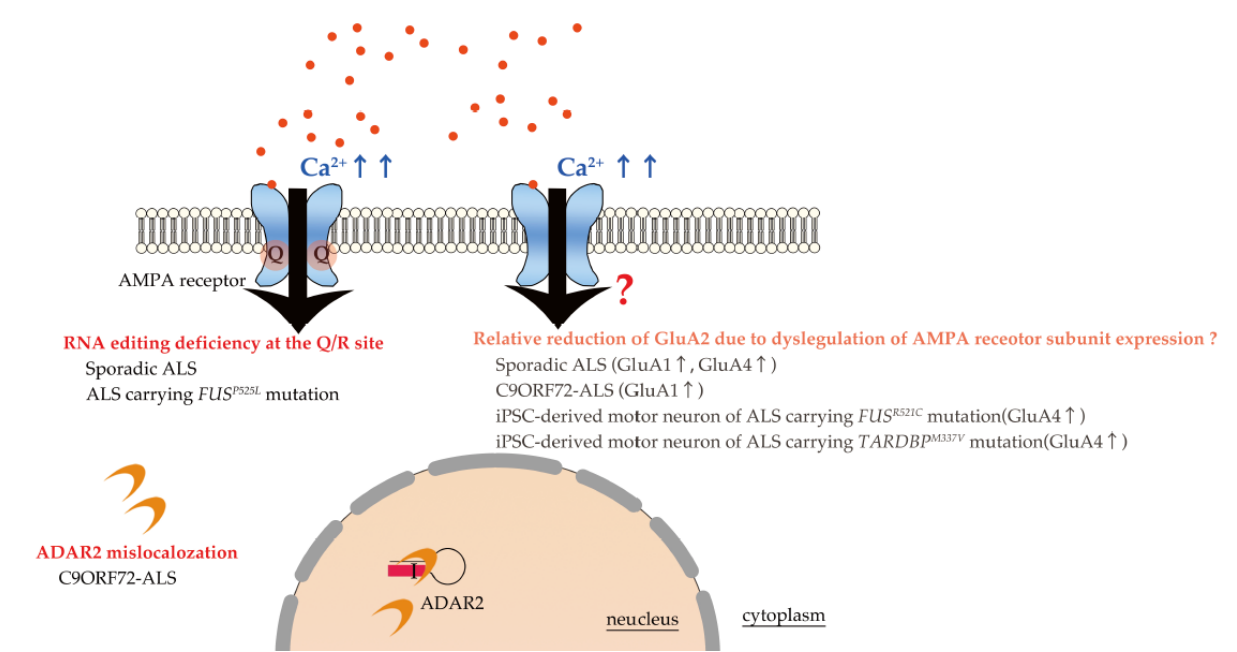
Figure 2. Excessive Ca 2+ influx through Ca 2+ -permeable AMPA receptors in ALS. Ca 2+ permeability of AMPA receptors (arrows) is determined by the presence or absence of Q/R site-edited GluA2 in the subunit assembly. RNA editing deficiency at the Q/R site in GluA2 due to downregulation of ADAR2 has been demonstrated in the motor neurons of patients with sporadic ALS and those carrying the FUS P525L mutation. Furthermore, ADAR2 mislocalization with loss of RNA editing activity has been reported in C9ORF72-ALS patients. Alterations in the expression of various AMPA subunits has been reported in sporadic ALS, C9ORF72 patients, and familial ALS patients carrying the FUS R521C and TARDBP M337V mutations; however, loss of GluA2 does not induce neuronal death in GluA2 knockout mice. Therefore, a relative reduction of GluA2 per se may not be pathological in causing motor neuron death in ALS. Then, the question mark near the arrow was added.